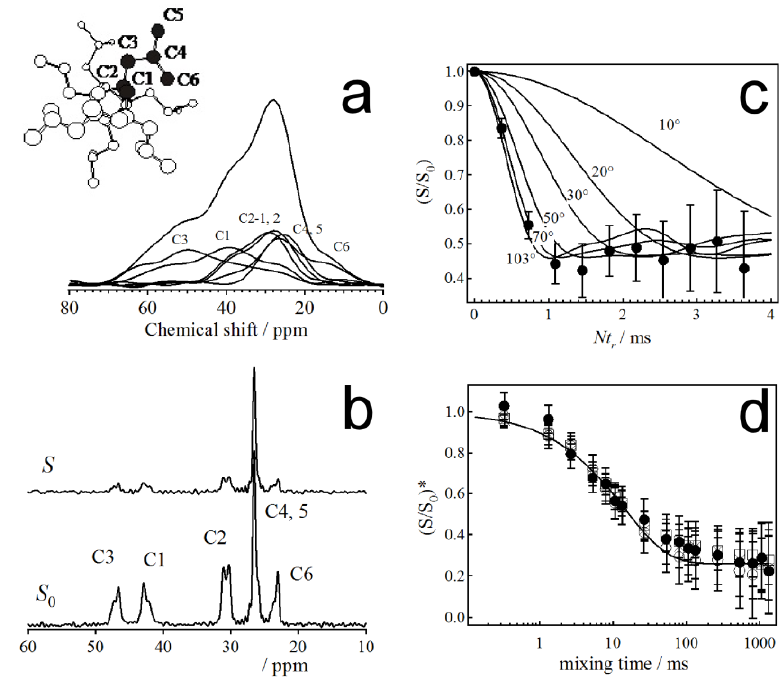
Figure 12. ( a ) i P4M1P 7 2 helical structure and corresponding chemical shift anisotropy (CSA) patterns. ( b ) Center-bands only of detection of exchange (CODEX) and reference spectra of i P4M1P